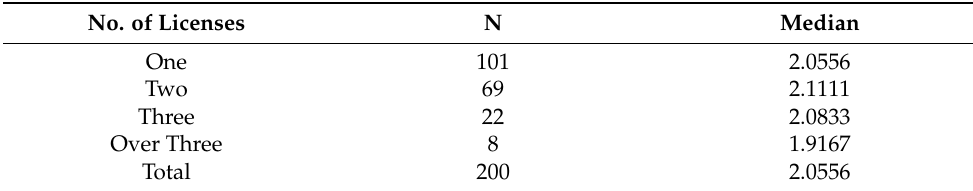
Table 6. Kruskal-Wallis One-Way ANOVA